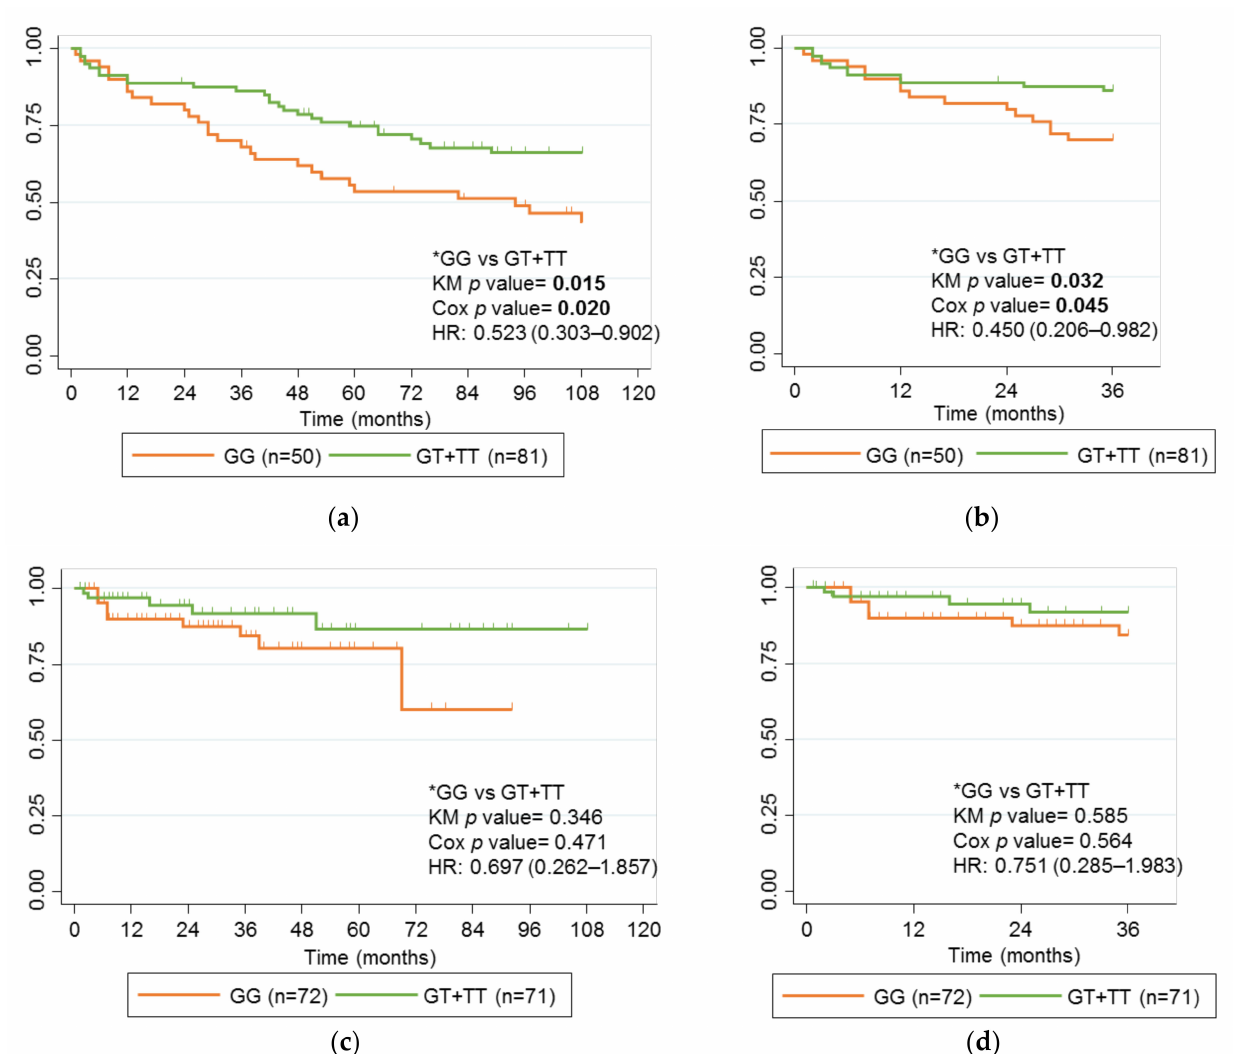
Figure 5. Kaplan-Meier curves for rs2395185 and failure of IFX in children and adults with CD. ( a ) Adults with CD treated with IFX, follow-up 9 years; ( b ) Adults with CD treated with IFX, follow- up 3 years; ( c ) Children with CD treated with IFX, follow-up 9 years; ( d ) Children with CD treated with IFX, follow-up 3 years. Genotype comparisons and p values for the univariate analysis (KM p value) and multivariate analysis (Cox p value) analyses are presented alongside Kaplan-Meier curves. Significant p values are marked in bold. * Reference